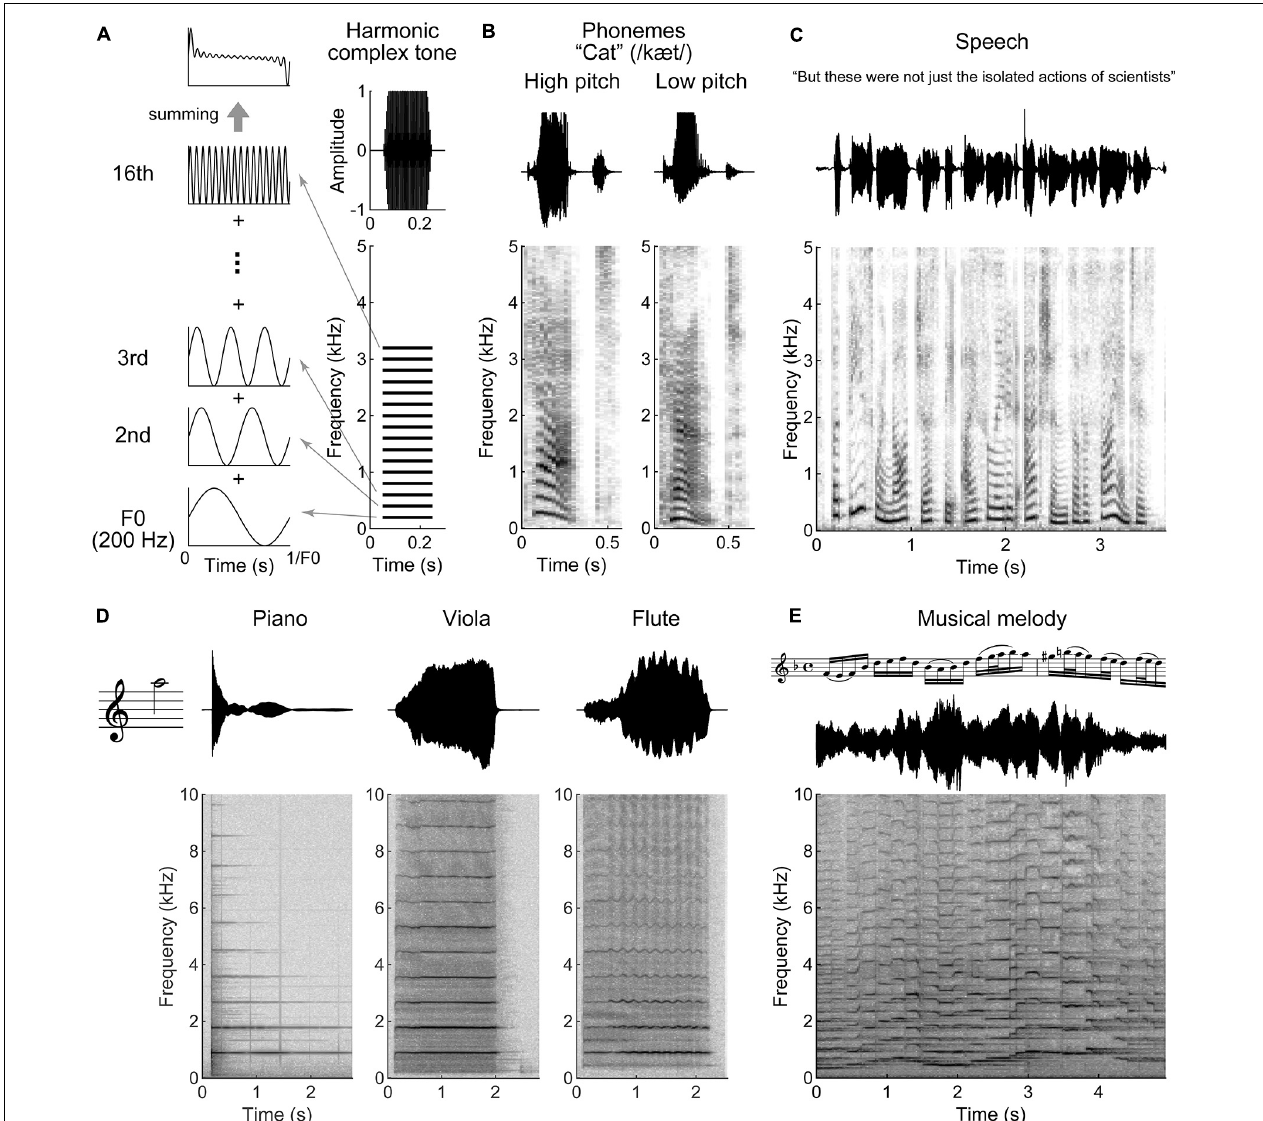
FIGURE 1 | Harmonic structures in speech and music. (A) Schematic illustration of a harmonic complex tone comprised 200 Hz fundamental frequency (F0) with 16 harmonics (right bottom). The 16 harmonics are integer multiples of F0. The right top indicates a total amplitude waveform of the tone. The left panels show waveforms of F0, 2nd, 3rd, and 16th harmonics. The periodicity of the harmonic complex tone, the sum of all the harmonics (left top panel), is equal to F0. (B–E) Waveforms (top) and spectrograms (bottom) for a segment of speech and music. (B) Female (high pitch) and male (low pitch) voices pronouncing, “cat.” The harmonic structures are observed around the vowel “a” (æ). (C) A segment of speech. Syllables occur every ∼ 0.2 to 0.5 s (2–5 Hz). (D) The instrumental tones played by piano, viola, and flute at 880 Hz F0 (A5 note). Although the tones evoke the same pitch sensation, their timbre differs as indicated with the waveforms and spectrograms. (E) A segment of musical melody played by violin. The tone pitch fluctuates faster than speech in this example (it could be slower dependent on tempo and